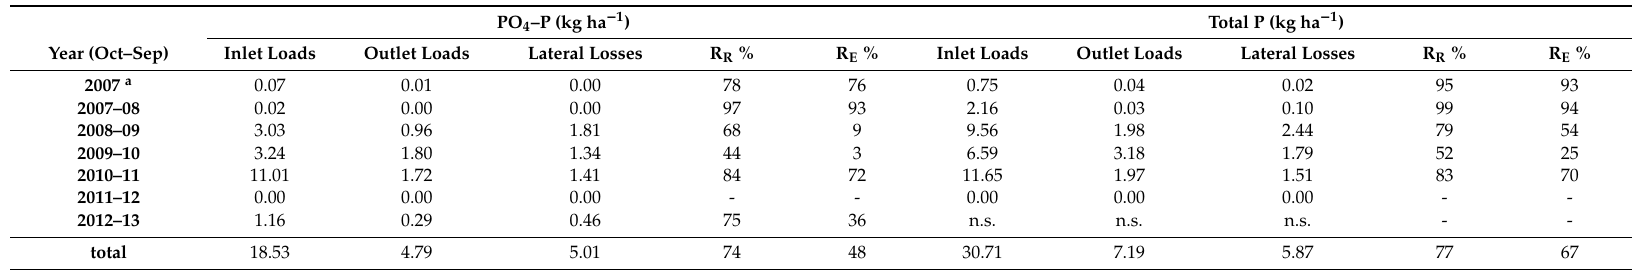
Table 4. SFCW phosphorus balance (PO 4 –P and total P). Inlet and outlet loads, estimated lateral losses, removal ratio (R R ), and removal e ffi ciency (R E ) are